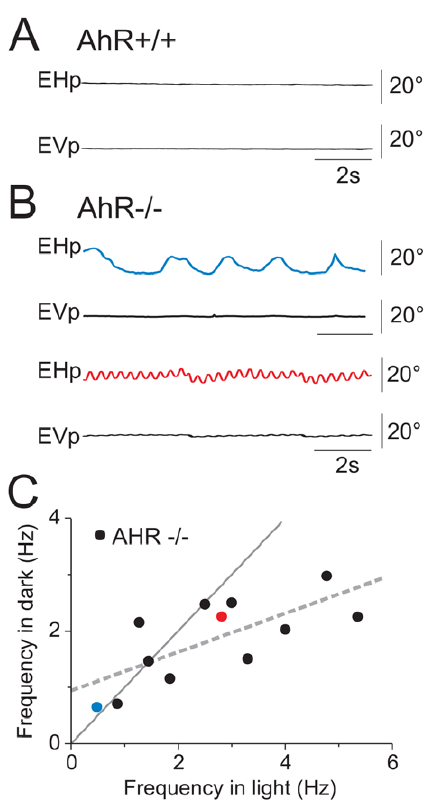
Figure 1. AhR 2 / 2 mice have a horizontal pendular nystagmus. (A) Positions of the eyes of the AhR + / + mice in both horizontal (EHp) and vertical (EVp) plans in the absence of head movements in the dark. (B) Positions of the eyes of 2 different AhR 2 / 2 mice showing spontaneous nystagmus at low frequency in light (upper) and at high frequency in dark (bottom). The AhR 2 / 2 mice have an ocular instability exclusively in the horizontal plan whereas the eyes of AhR + / + mice and AhR + / 2 mice are stable. (C) Frequencies of the nystagmus in light and dark conditions for each AhR 2 / 2 mouse (n=12). The linear regression is represented by the dotted line in grey. EHp: Eye Horizontal position; EVp: Eye vertical position. In this and all following figures, eye movements to the right are presented